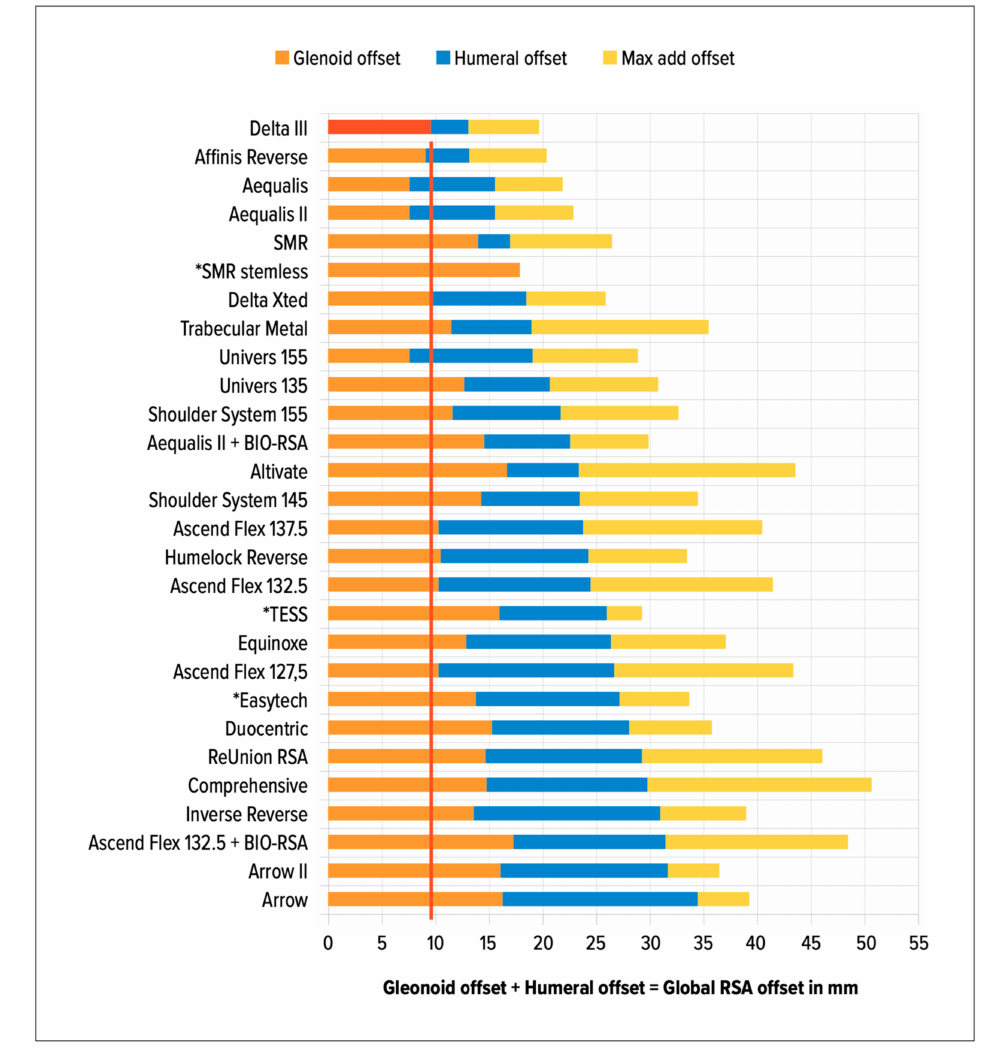
Figure 3. Baseline (red) representing Delta III glenoid-sided lateralization as a reference (* Stemless). Yellow: Maximal additional offset as a result of GS size/other parameters. Figure consistent with Werthel’s data